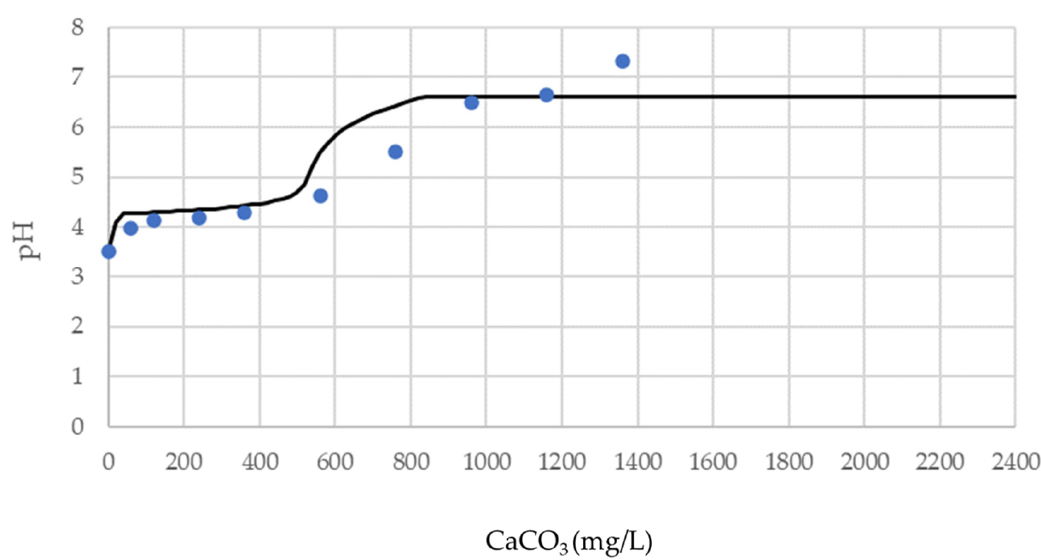
Figure 12. Leached buffered sample FA4, modeling geochemical curve (black line) compared with values of buffering test (blue circles). Liquid samples FA4-S and FA4-L represent the buffered points where respective precipitates were collected.